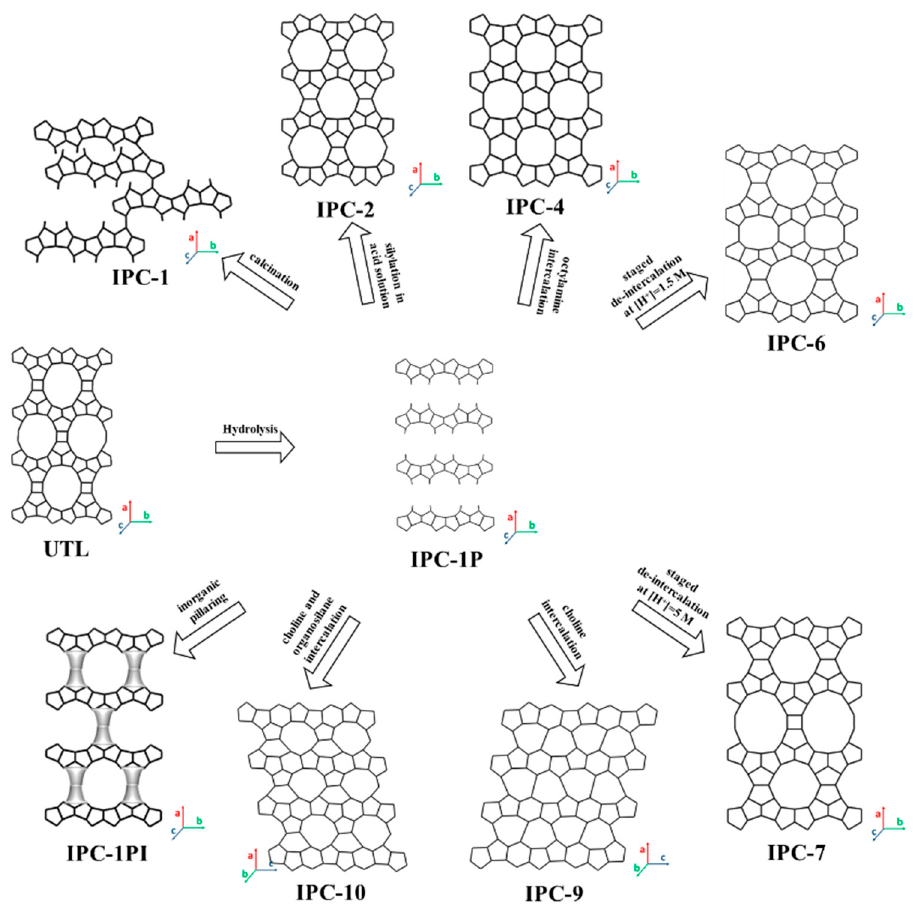
Figure 10. Schematic illustration of structures and processes for producing 2D layered intermediate and 3D or 2D zeolite derivatives by the ADOR method.